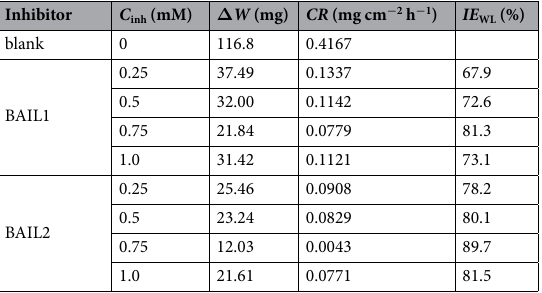
Table 3. Corrosion parameters for carbon steel immersed in 0.5 M HCl solution for 24 h without/with different concentrations of BAIL1 and BAIL2 at 298 K obtained from WL